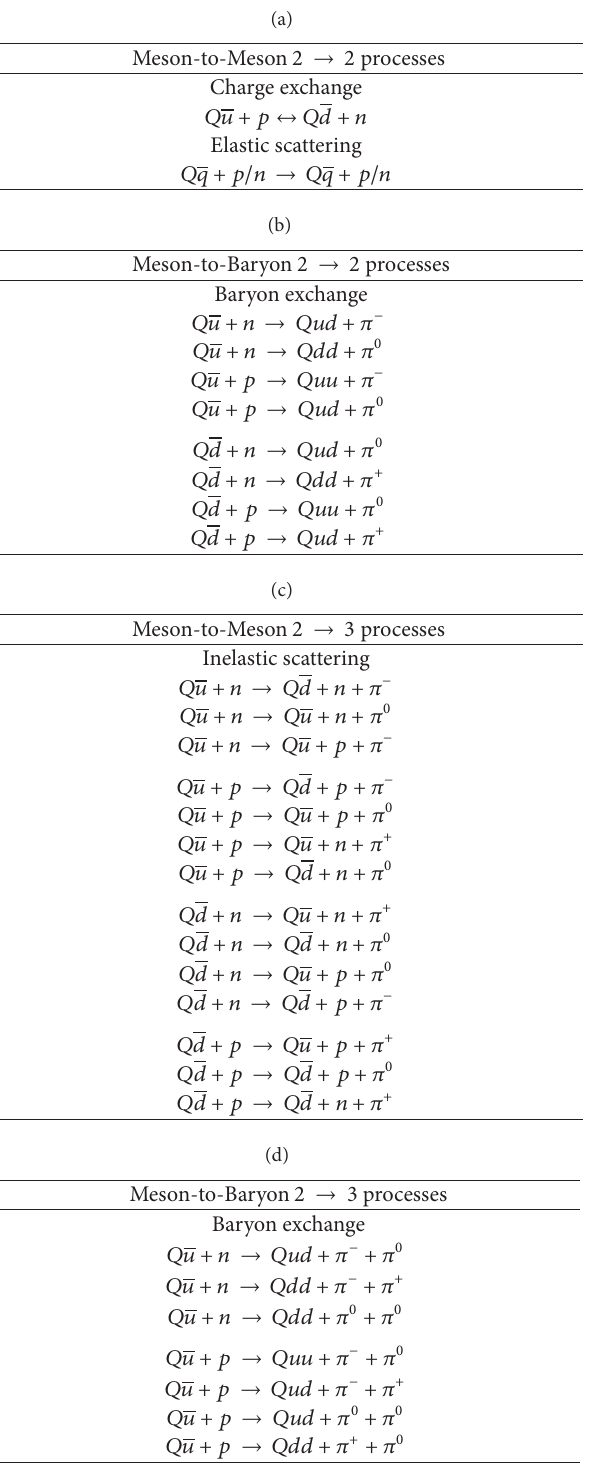
Table 6: Meson-to-Meson and Meson-to-Baryon processes for 𝑄𝑢 and 𝑄𝑑 mesonic states, where 𝑄 = 𝑋 5/3 ,𝑇 2/3 , 𝐵 −1/3 ,𝑌 −4/3 and 𝑞 = 𝑢, 𝑑 . Similar transitions can be obtained for the charge conjugated processes involving 𝑄𝑞 . Assuming that the cross-sections for all the transitions are of the same order of magnitude, Meson-to-Baryon processes to 𝑄𝑢𝑑 states are more likely than those involving 𝑄𝑢𝑢 and 𝑄𝑑𝑑 in the final